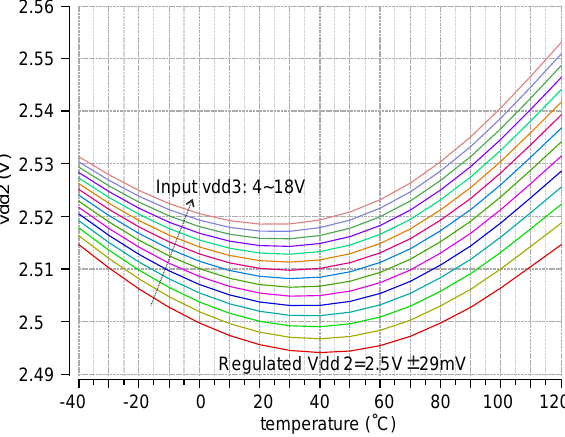
Figure 7. Post layout transient analysis sweep of the 2.5 HV LDO with 2 KHz and 1 mA switching load.